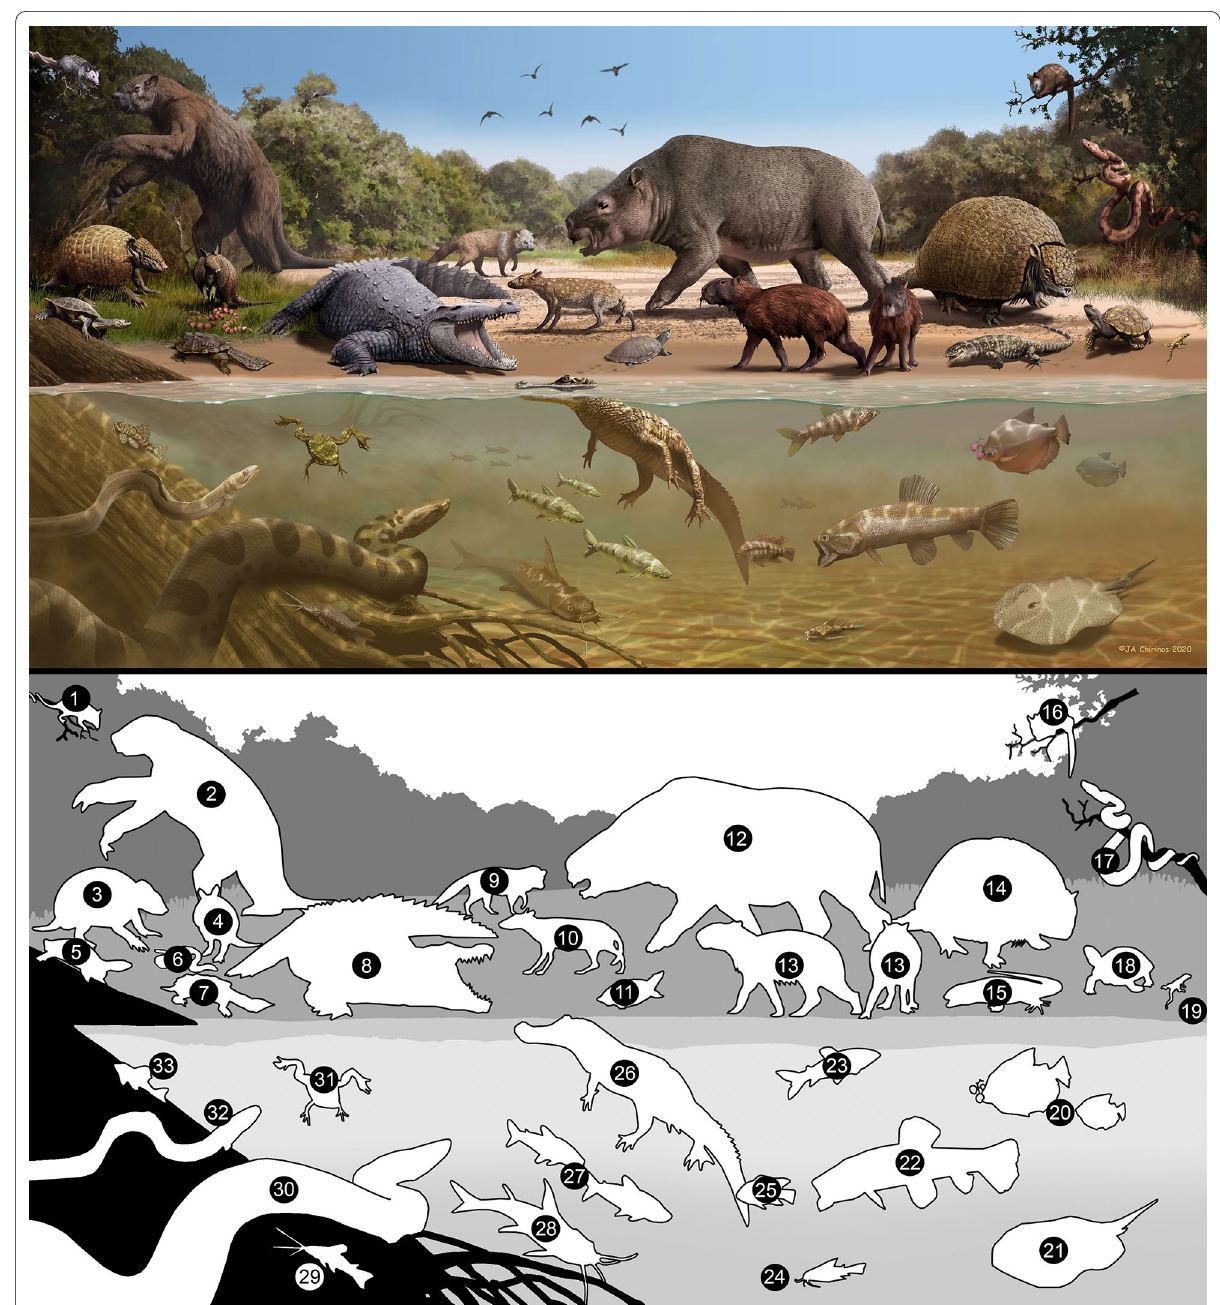
Fig. 35 (Top) Life reconstruction of the San Gregorio Formation faunal assemblage, Falcón Basin, Venezuela. Artist: Jaime Chirinos. (Bottom) Key of the reconstruction. (1) cf. Didelphis sp. (2) cf. † Proeremotherium sp. (3) aff. † Holmesina floridanus . (4) † Pliodasypus vergelianus . (5) Podocnemididae indet. (6) Anilius scytale . (7) Chelus sp. (8) † Crocodylus falconensis . (9) † Cyonasua sp. (10) †Interatheriidae indet. (11) Podocnemididae indet. (12) † Falcontoxodon sp. (13) †? Hydrochoeropsis wayuu . (14) aff. † Boreostemma sp. (15) Tupinambis s.l. (16) † Marisela gregoriana . (17) Corallus sp. (18) Chelonoidis sp. (19) Lizard. (20) Mylossoma sp. (21) Potamotrygon sp. (22) Hoplias sp. (23) Schizodon cf. S . corti . (24) cf. Amblydoras sp. (25) Cichlidae indet. (26) Caimaninae indet. (27) cf. Megaleporinus sp. (28) cf. Sciades sp. (29) Callichthyidae indet. (30) Eunectes sp. (31) cf. Pipa sp. (32) Synbranchus sp. (33) Suckermouth catfish